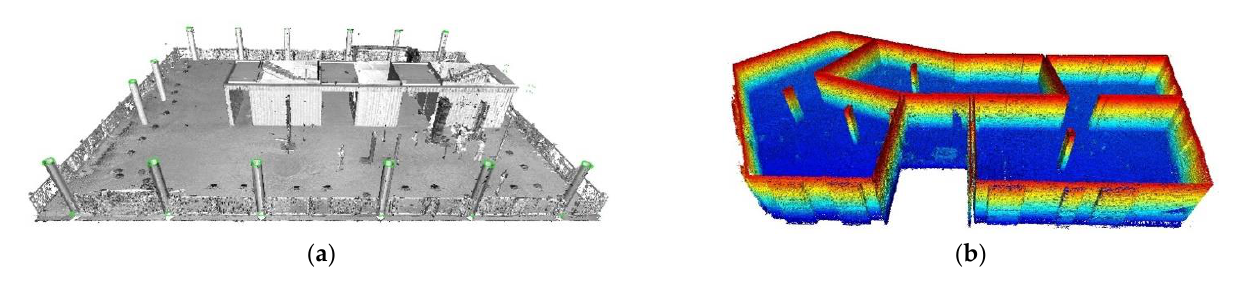
Figure 11. Final alignment of the source and target point cloud data after applying the Iterative Closest Point (ICP) method: ( a ) the data was obtained using the FARO Focus S scanner from the third floor of the office building, and ( b ) the data was obtained using the ZEB-GO scanner from the residential building.